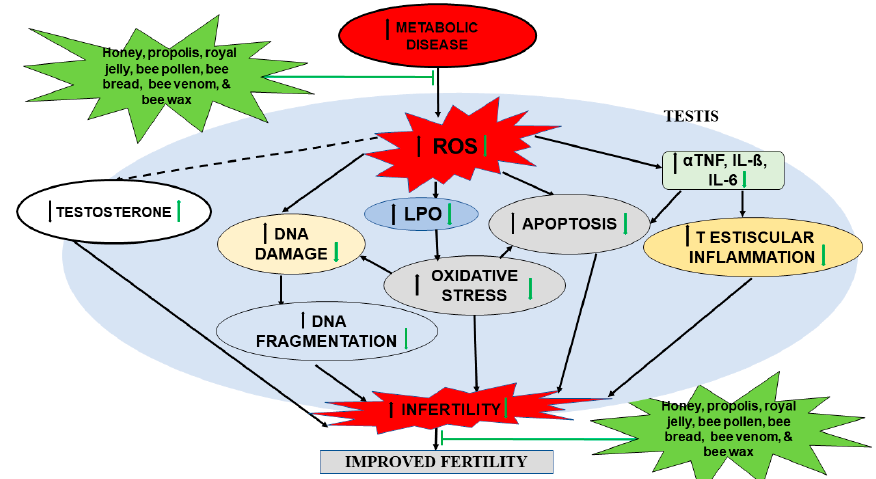
Figure 2. Summary of the effects of bee products on male reproductive impairment (adapted from [60]). DNA: deoxyribonucleic acid; IL-6: interleukin 6; IL-ß: interleukin ß; LPO: lipid peroxidation; α TNF: α -tumor necrotic factor; ROS: reactive oxygen species.